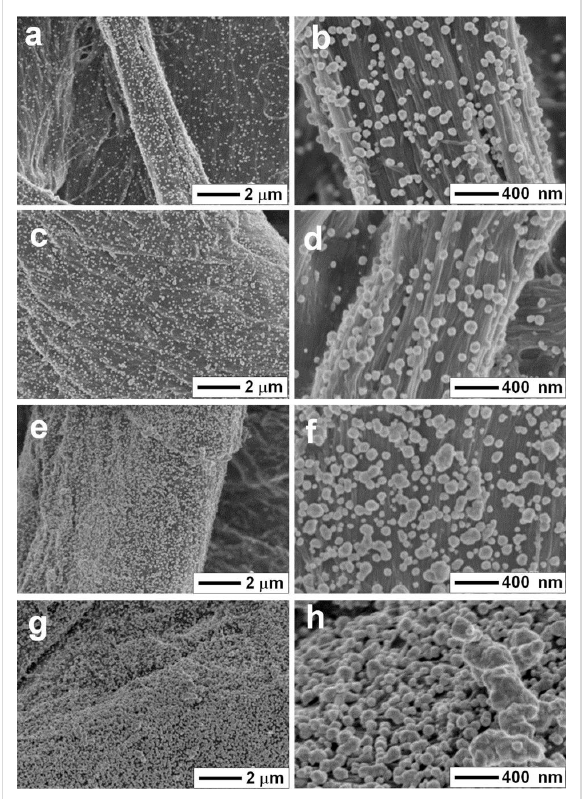
Figure 1: FE-SEM micrographs of the paper-based SERS substrates Ag-NP/cellulose-NF–A (a,b), B (c,d), C (e,f), and D (g,h), which were fabricated with reaction times of 2, 4, 6, and 8 min,